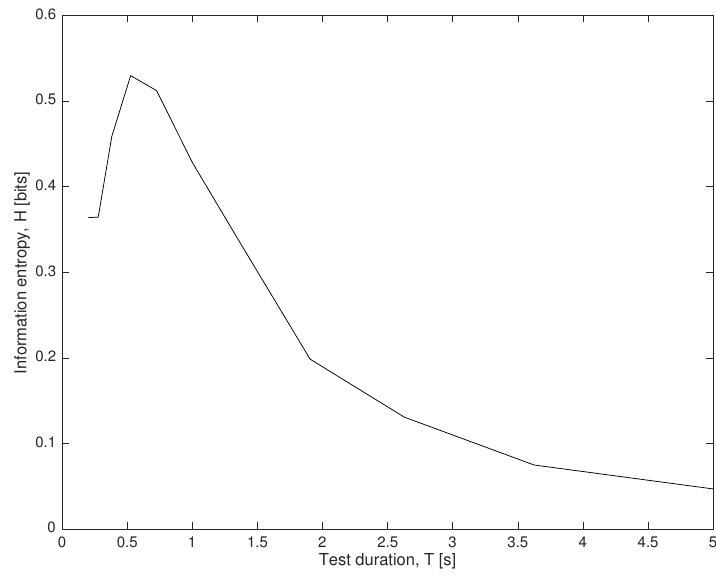
Figure 8. Interrogation system